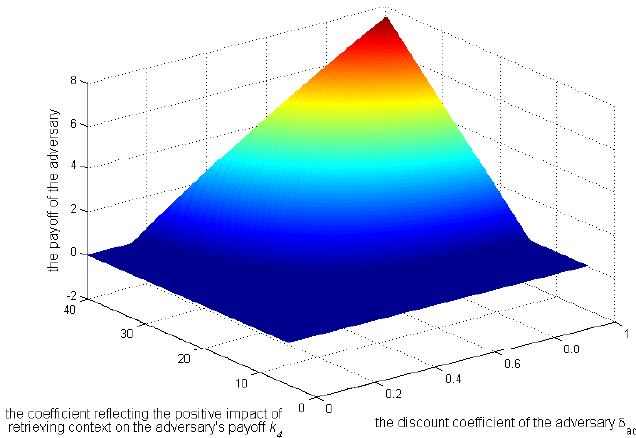
Figure 11. Impact of k 4 and δ ad on the adversary’s payoffs.